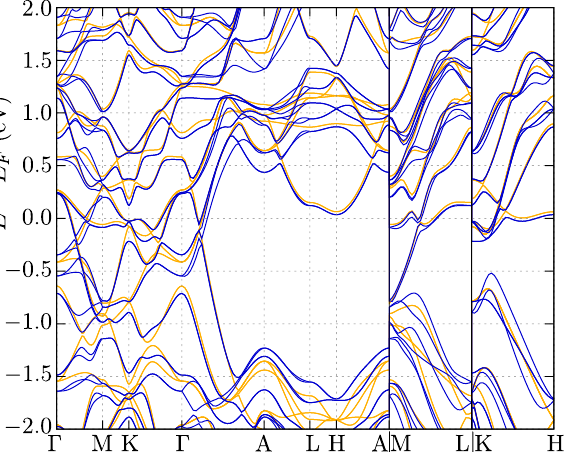
Figure 6. The electronic band structure along high symmetry directions for the P¯62m symmetry in the absence and presence of spin–orbit coupling (orange and blue lines, respectively).